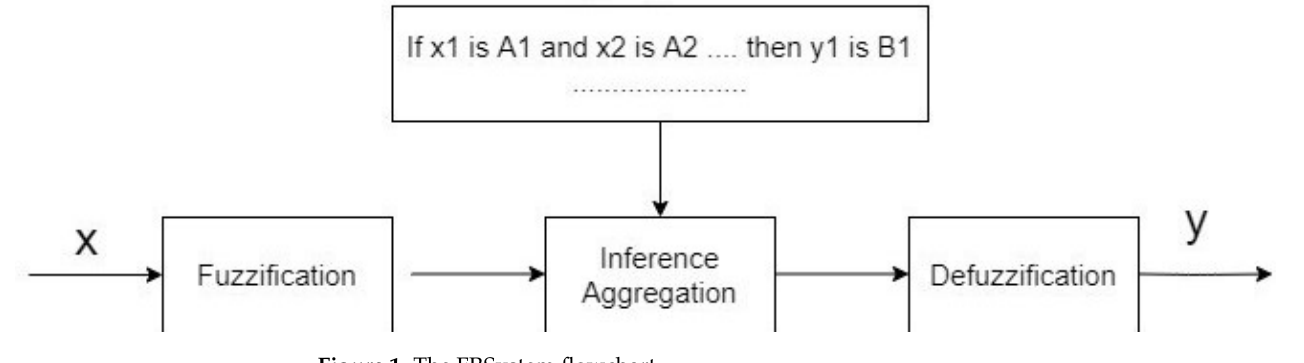
Figure 1. The FRSystem